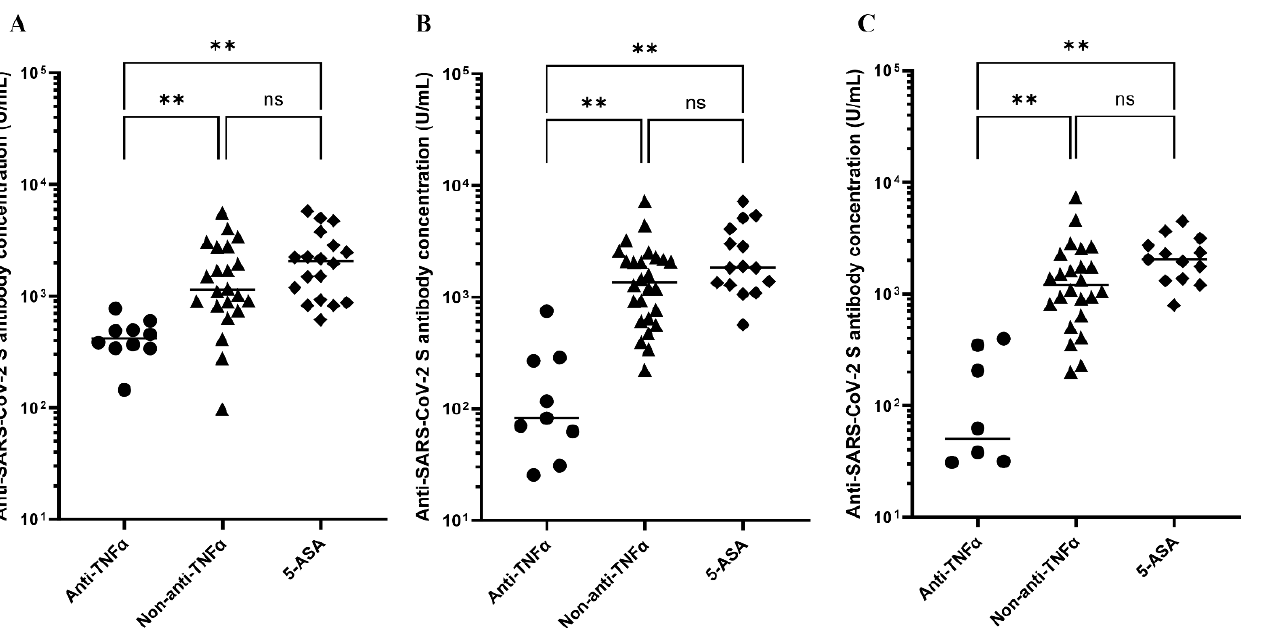
Figure 1. Anti-SARS-CoV-2 S antibody concentrations (U/mL) after the initial two-vaccine series. ( A ) Antibody titers of PIBD patients 3–9 weeks after the initial two-vaccine series. ( B ) Antibody titers of PIBD patients 10–16 weeks after the initial two-vaccine series. ( C ) Antibody titers of PIBD patients 20–28 weeks after the initial two-vaccine series. TNF = tumor necrosis factor, 5-ASA = 5-aminosalicylic acid. For multiple comparisons, Brown-Forsythe and Welch analysis of variance followed by the Dunnett T3 correction was used, and p -values < 0.05 were considered significant. ** indicates p -values < 0.01, and ns indicates not